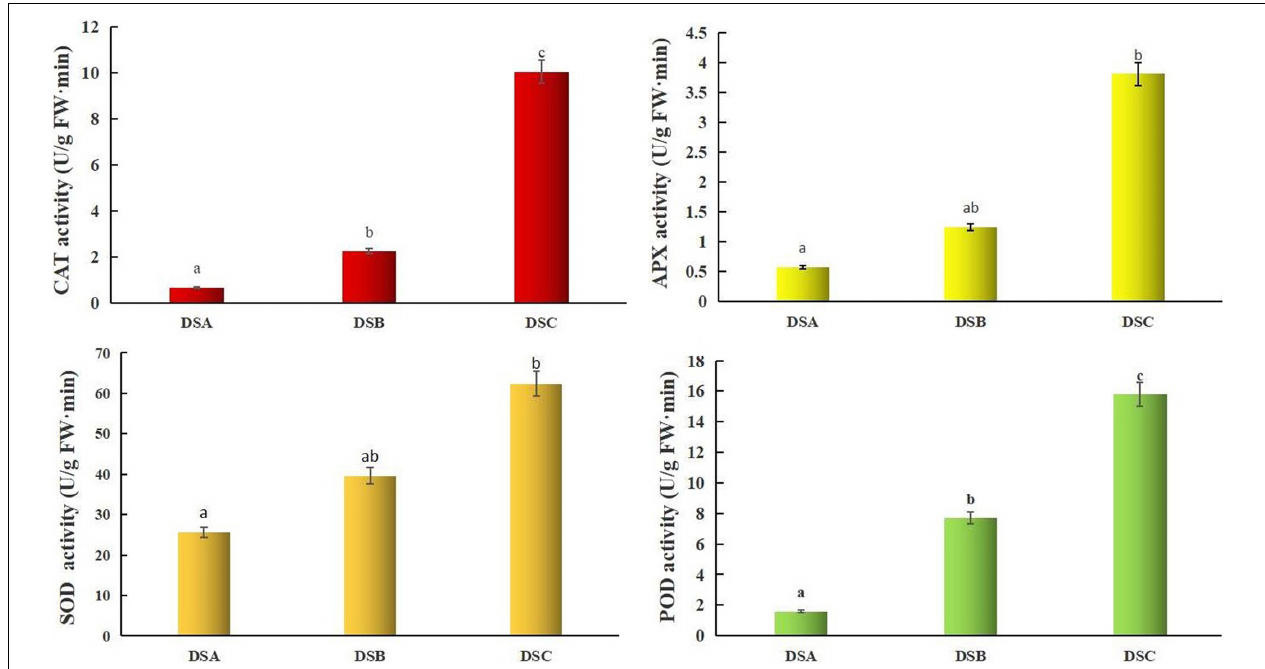
FIGURE 1 | Effects of drought stress on physiological and biochemical parameters in pseudobulb of D. sinense . Data are means ± SE of three separate measurements. The significance of differences was analyzed using Duncan method.